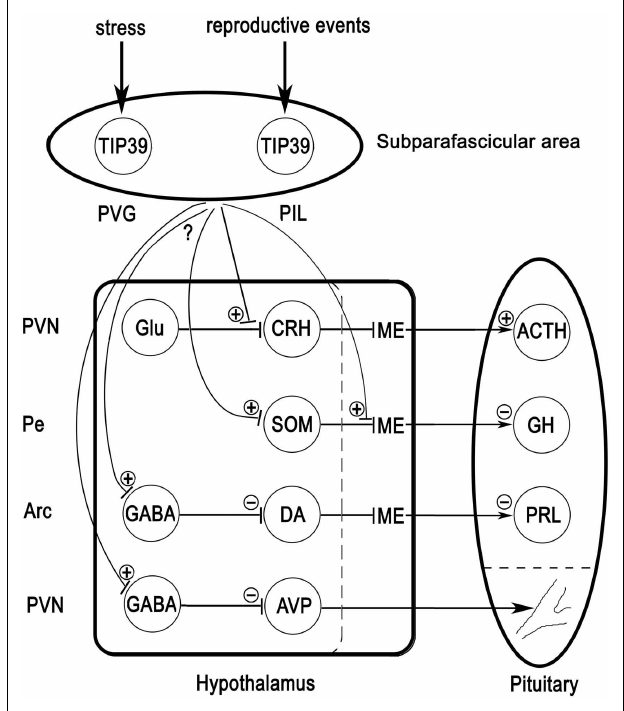
FIGURE 5 | Potential mechanisms of actions ofTIP39 via the PTH2R. TIP39 neurons in the PVG receive information on threats to homeostasis while those in the PIL receive various inputs related to reproduction. Axon terminals arising from theseTIP39 neurons may facilitate excitatory synapses by presynaptic actions. A well-documented example is the action ofTIP39 on glutamatergic synapses terminating on CRH neurons in the PVN. Another possible route to influence hypothalamic hormone release is via terminals of hypophysiotropic neurons in the median eminence (ME) as has been suggested for somatostatin. Neurons that express PTH2Rs in their cell bodies may be directly affected byTIP39. Some actions ofTIP39 including those on prolactin and AVP release, seem to be mediated by inhibitory neurons.TIP39 terminals might innervate cell bodies of GABAergic cells or alternatively, presynaptic terminals leading to the activation of inhibitory neurons (not shown). Additional abbreviations: ACTH, adrenocorticotropin; Arc, arcuate nucleus; DA, dopamine; GH, growth hormone; Glu, glutamate; Pe, periventricular hypothalamic nucleus; PRL, prolactin; SOM,